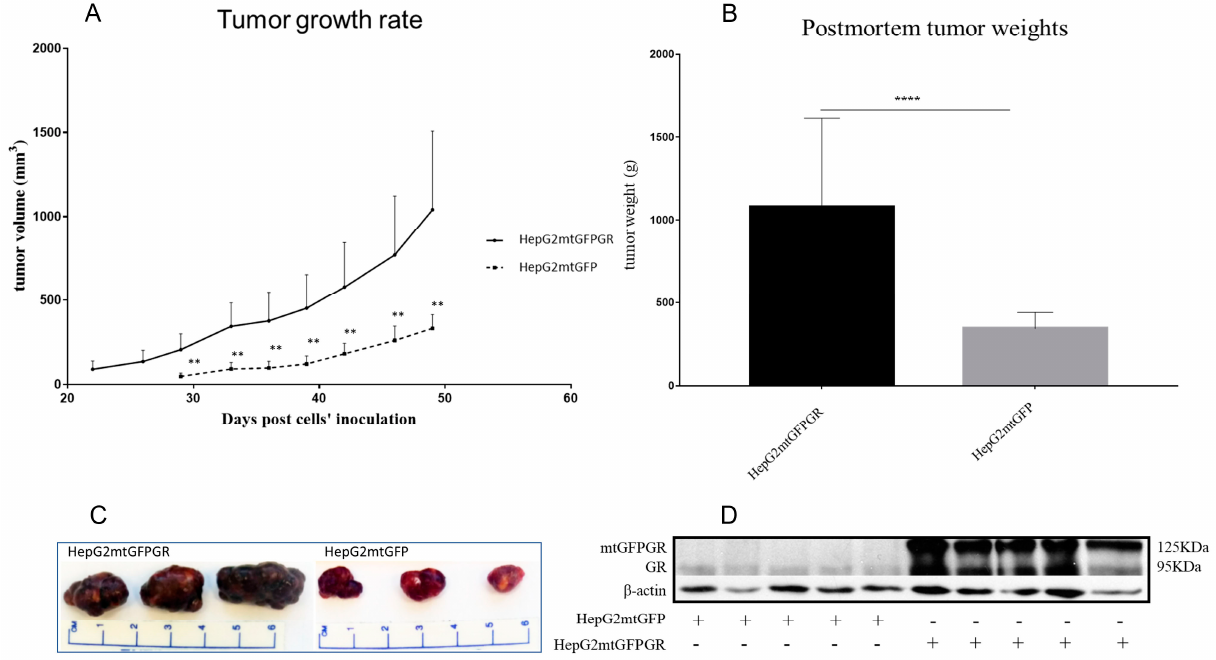
Figure 1. mtGR-induced increase in tumor progression in NOD/SCID mice inoculated with 1 × 10 6 HepG2mtGFP or HepG2mtGFPGR cells. ( A ) The growth rates of the tumors in NOD/SCID mice and ( B ) postmortem weights of the tumors excised from the mice upon termination of the experiment. Each point shows the mean ± SD ( n = 15–16, 8 mice per group), ** p < 0.01, **** p < 0.0001, compared to the HepG2mtGFP group. ( C ) Representative images of tumors from the two groups. ( D ) Western blot analysis of the expression of mtGR from five representative tumors from each group.